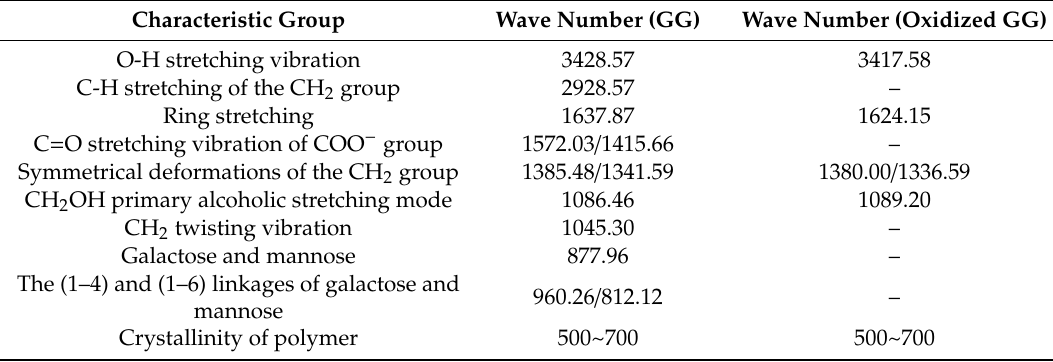
Table 2. Characteristic FT-IR wave numbers of GG and oxidized